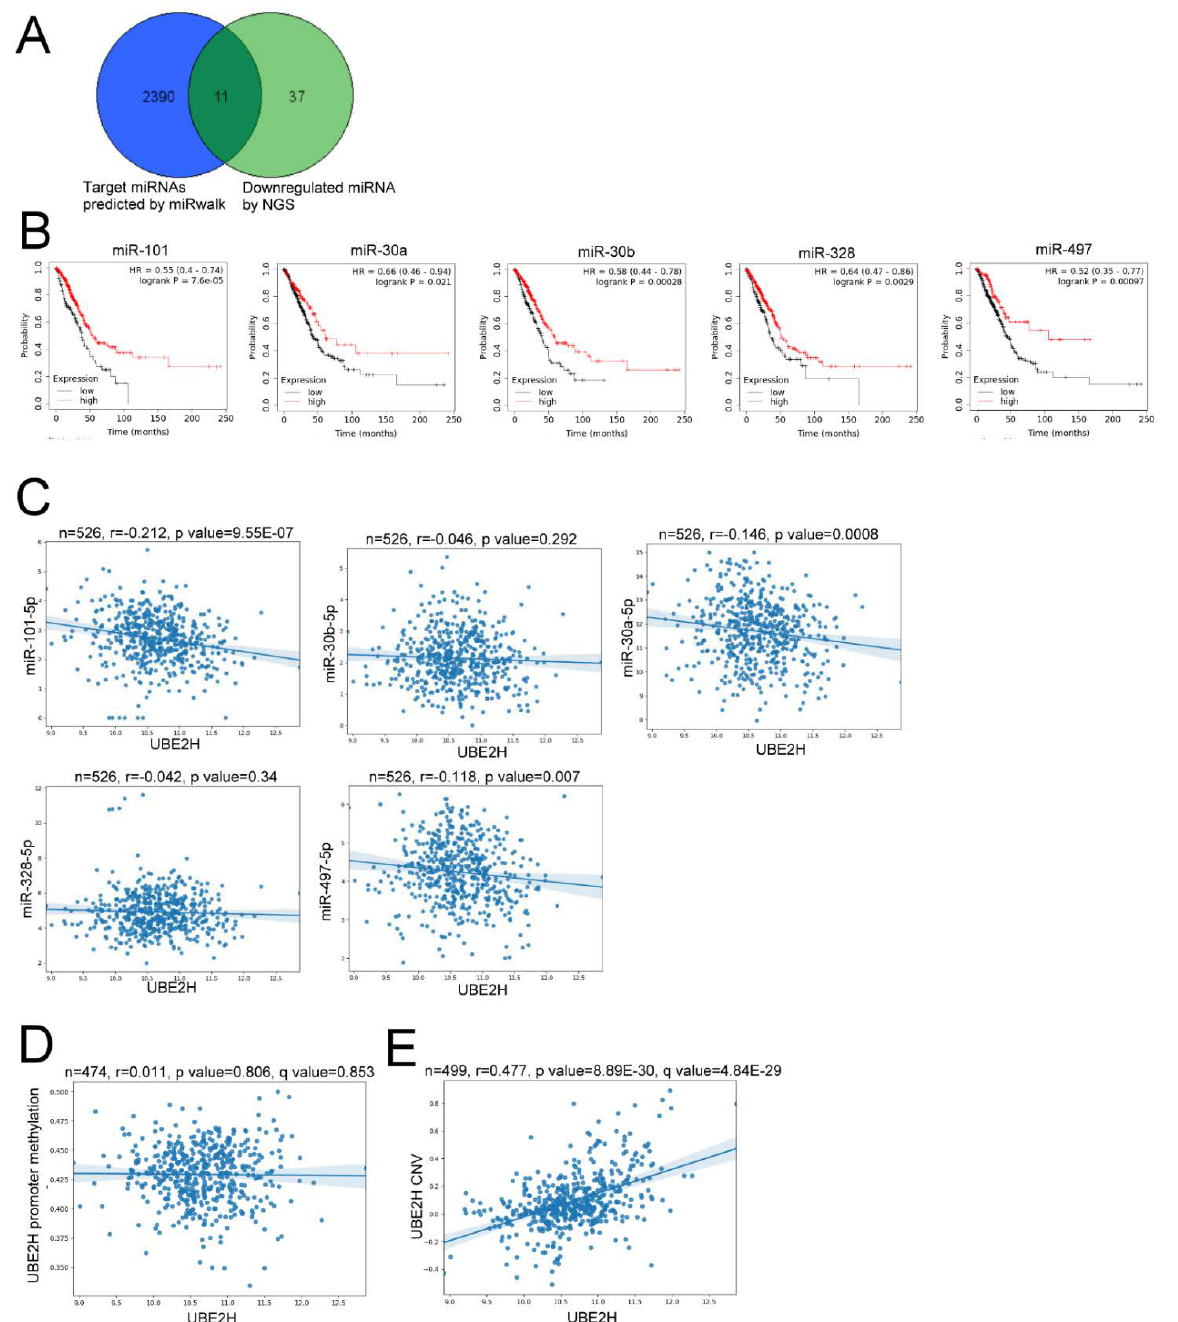
Figure 4. The potential regulatory mechanism of UBE2H. ( A ) 11 shared genes are identified from the 2390 candidate UBE2H-targeted miRNAs (blue circle) predicted by miRWalk and 37 down-regulated miRNAs from RNA sequencing (green circle). ( B ) The survival analysis via the KM plotter. The samples are divided by the median expression value of each miRNA. ( C ) The correlation between the expression of UBE2H and the expression of each miRNA. ( D ) The correlation between the expression of UBE2H and the methylation status of the UBE2H promoter. ( E ) The correlation between the expression of UBE2H and the copy number variation (CNV) among the LUAD samples of